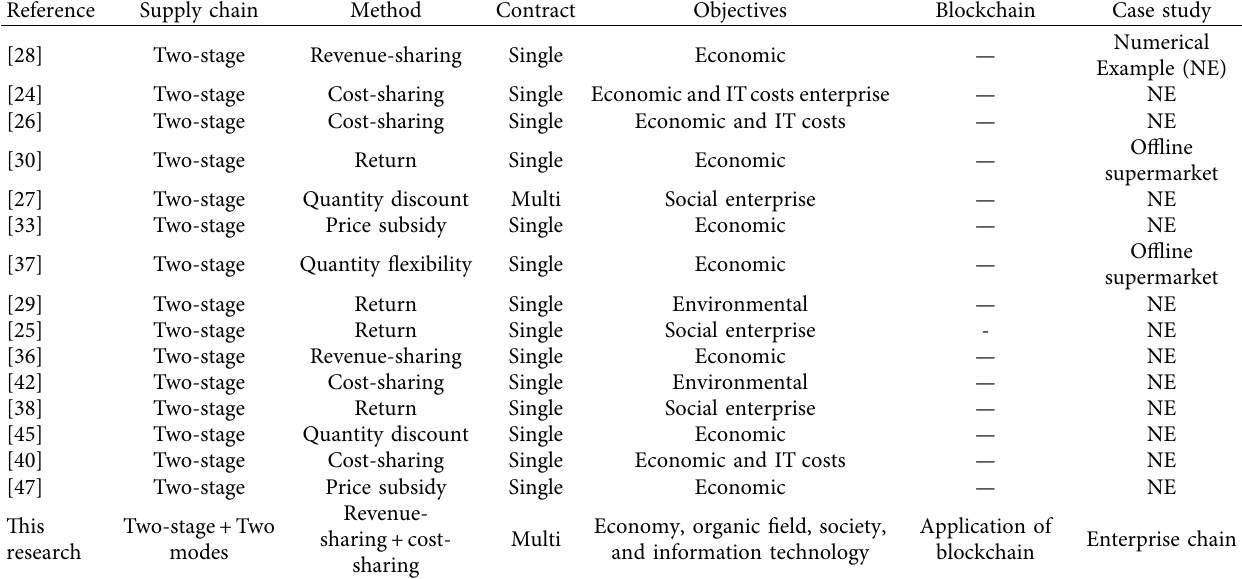
Table 1: Classification and survey of organic food supply